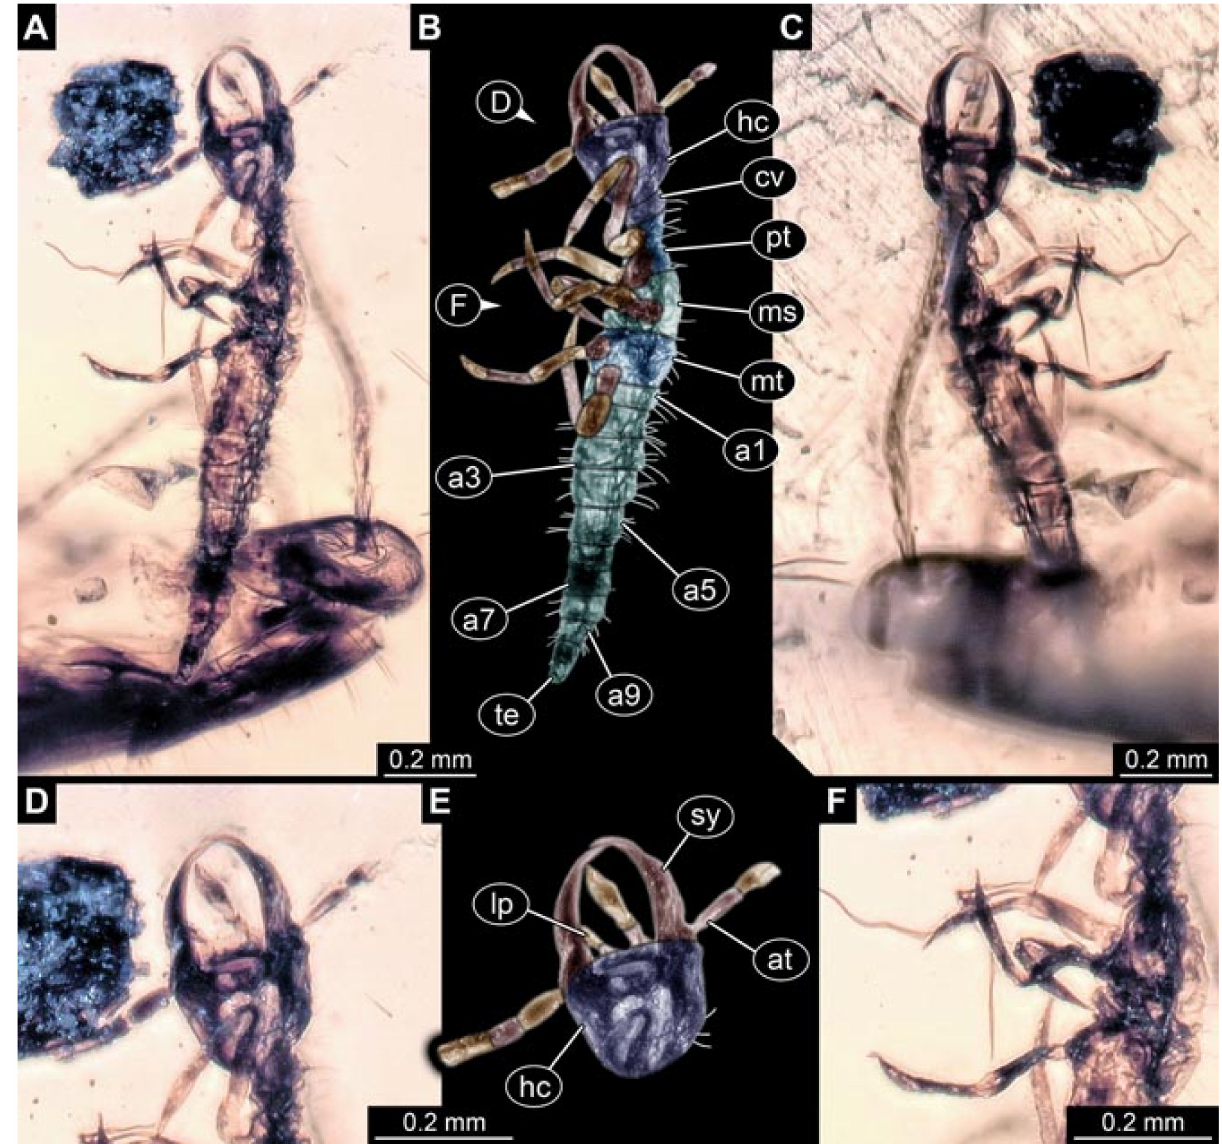
Figure 23. Specimen 5854 (PED 0823); Myanmar amber. ( A ) Ventral view. ( B ) Ventral view, colour-marked. ( C ) Dorsal view. ( D ) Close-up of head in ventral view. ( E ) Close-up of head in ventral view, colour-marked. ( F ) Close-up of trunk appendages. Abbreviations: a1–a9 = abdomen segments 1–9; at = antenna; cv = cervix; hc = head capsule; lp = labial palp; ms = mesothorax; mt = metathorax; pt = prothorax; sy = stylet; te = trunk